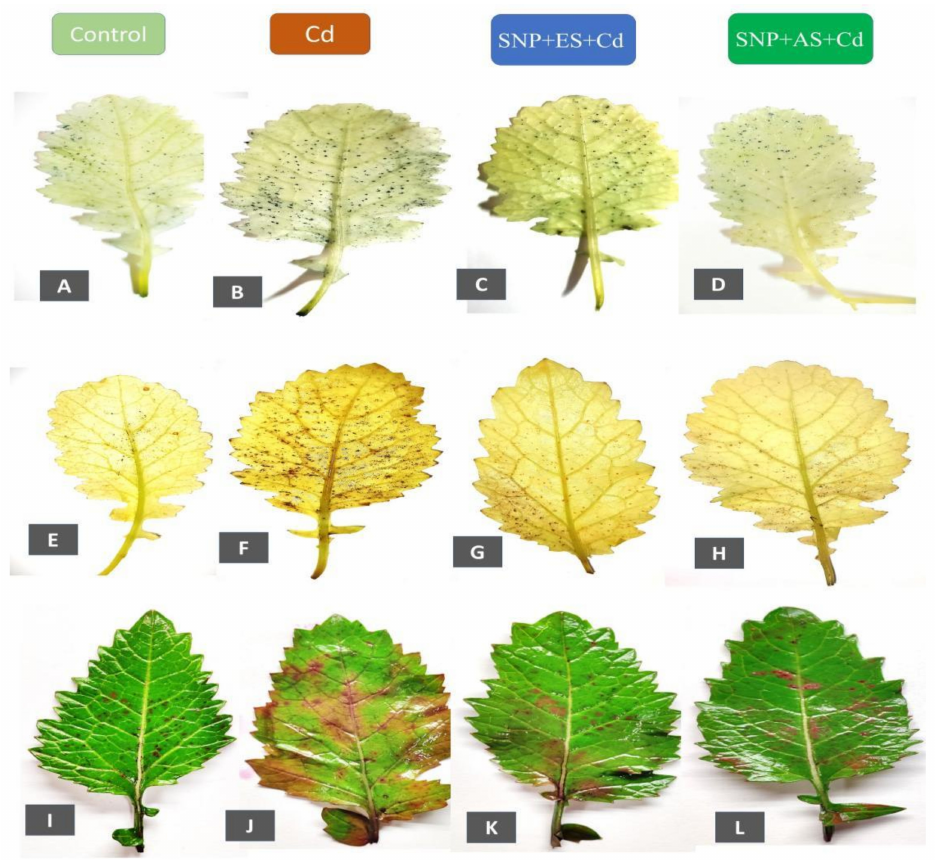
Figure 3. Histochemical detection of: superoxide anion (O 2 •− ) with NBT ( A – D ); hydrogen peroxide (H 2 O 2 ) with DAB ( E – H ), and lipid peroxidation using Schiff’s reagent ( I – L ) in leaves of mustard ( Brassica juncea L. cv. Giriraj) treated with control ( A , E , I ) 200 mg Cd kg − 1 soil; ( B , F , J ) 100 µ M of SNP (NO donor) + 200 mg S kg − 1 soil of elemental sulfur (ES) in presence of Cd ( C , G , K ); and 100 µ M of SNP + 200 mg S kg − 1 soil of ammonium sulfate (AS) in presence of Cd ( D , H , L ) at 30 days after sowing. Cd; Cadmium; cv., cultivar; DAB, 3,3 (cid:48) -diamiobenzidine; ES, elemental sulfur; H 2 DCFDA, 2 (cid:48) ,7 (cid:48) -dichlorodihydrofluorescein diacetate; NBT, nitro blue tetrazolium; SNP, sodium